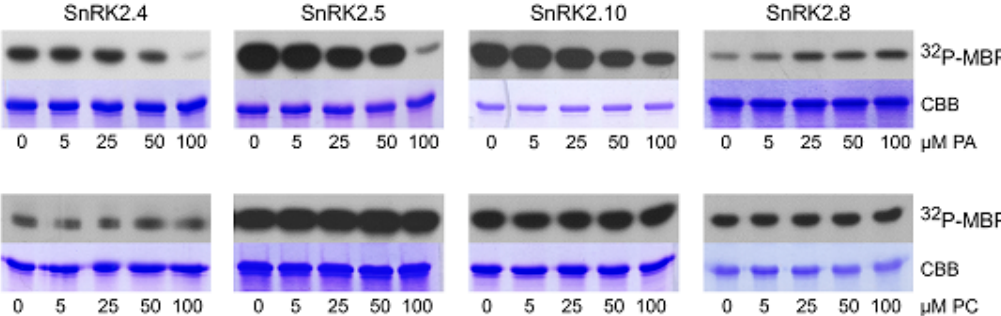
Figure 3. Effect of PA on activity of SnRK2s. The in vitro activity of bacterially expressed and purified kinases in fusion with GST (ABA-non-activated SnRK2.4, SnRK2.5, and SnRK2.10, and ABA weakly activated SnRK2.8, about 1 µ g each) was measured in the presence of increasing amounts of PA 16:0 / 18:1 (upper panel) or PC (lower panel) in a reaction mixture with myelin basic protein (MBP) and [ γ 32 P]ATP as substrates. Reaction products were separated by SDS-PAGE, and the extent of MBP phosphorylation was determined by autoradiography. 32 P-MBP—autoradiography; CBB—Coomassie Brilliant Blue staining. Data represent one of three independent experiments showing similar results.